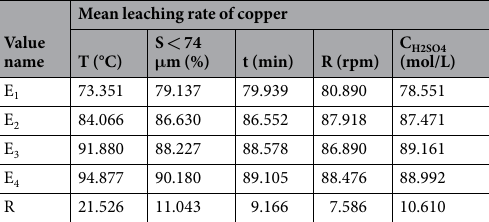
Table 4. Range analysis data of copper leaching rate.